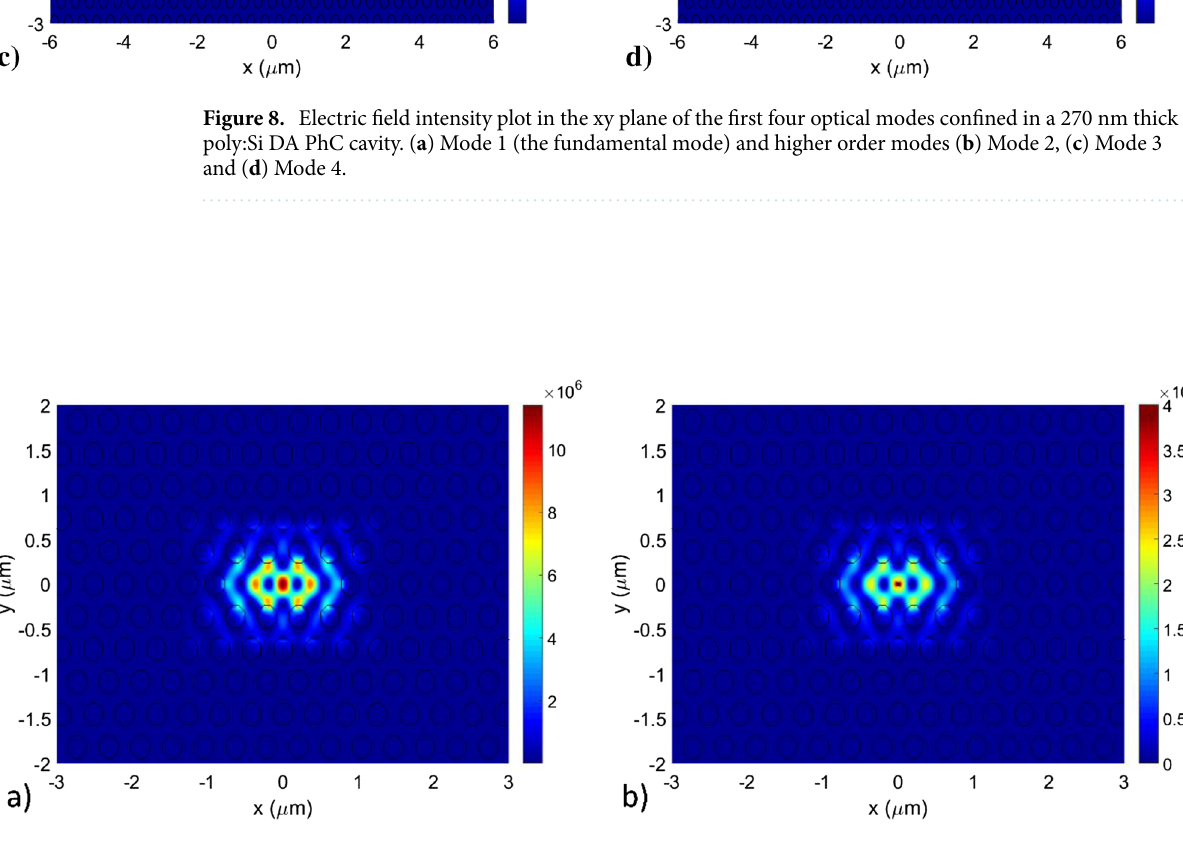
Figure 9. Electric field intensity plot in the xy plane of the first four optical modes confined in a 270 nm thick poly:Si L3 PhC cavity. ( a ) Mode 1 (the fundamental mode) and ( b ) higher order mode (Mode